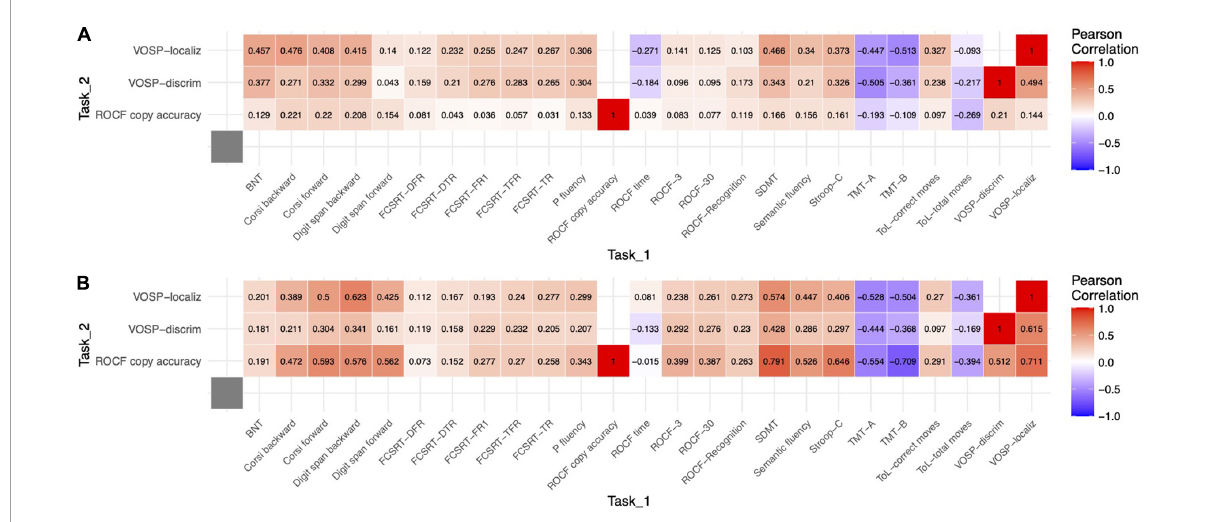
FIGURE2 Heat map of Pearson correlations between visuospatial tasks and the other neuropsychological tests. (A) bvFTD. (B) AD.